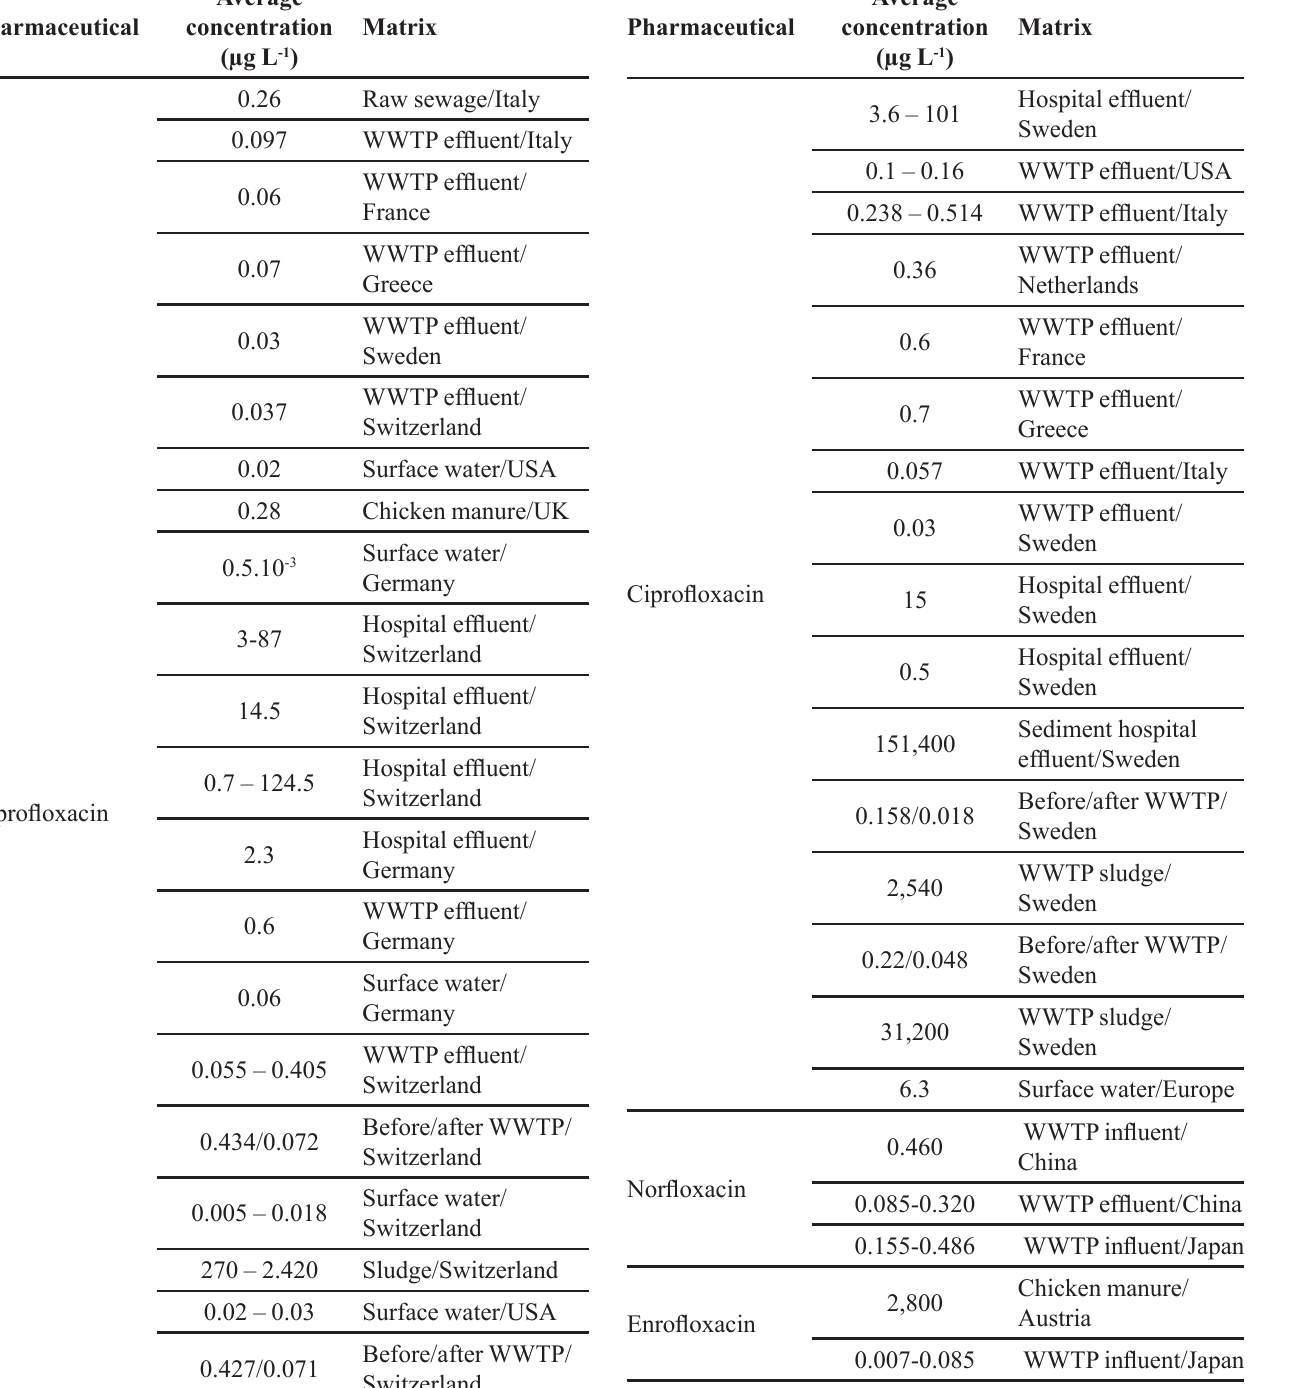
TABLE I - Environmental concentrations of fluoroquinolones (Vasconcelos, 2006; Tambosi, 2008; Melo et al ., 2009; Gosh et al ., 2009; Regitano and Leal, 2010)